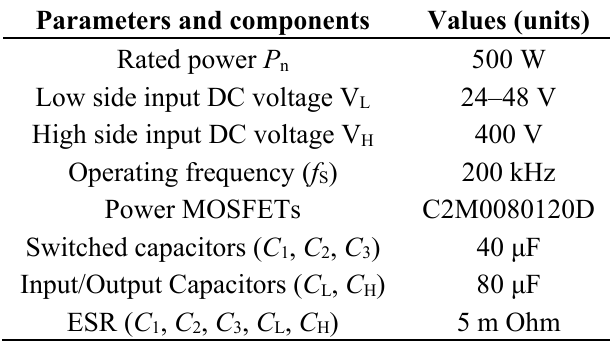
Table 1. Specifications of the prototype